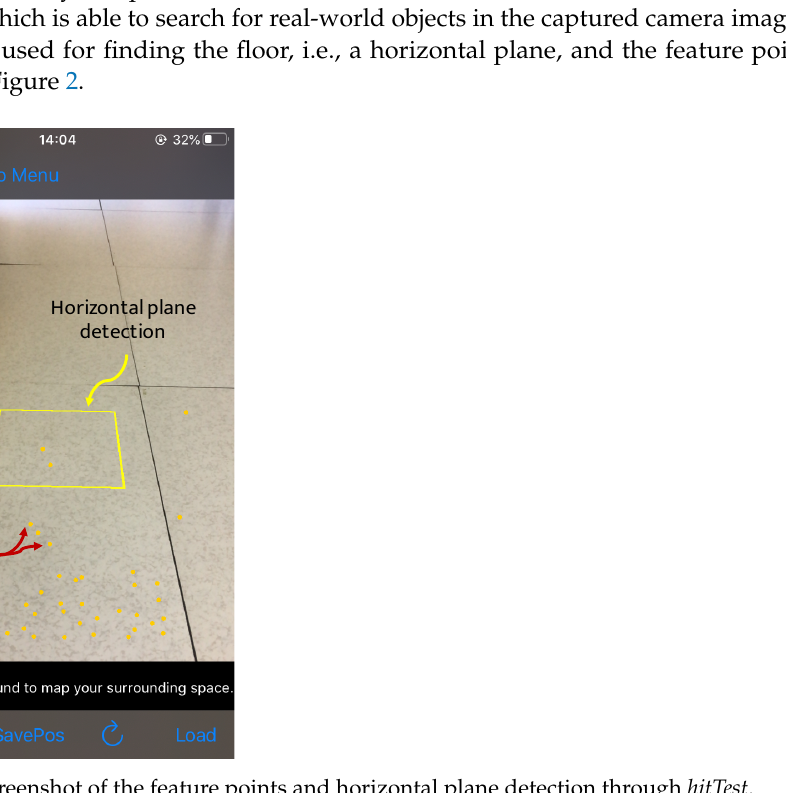
Figure 2. Screenshot of the feature points and horizontal plane detection through hitTest